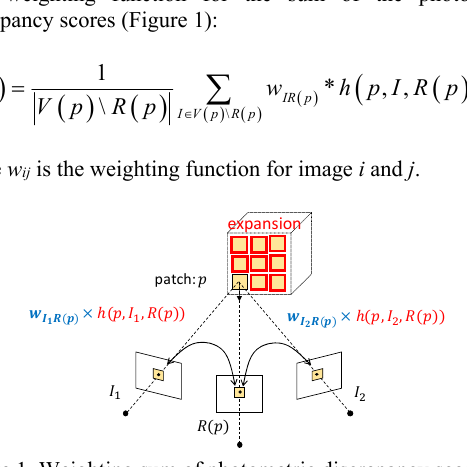
Figure 1. Weighting sum of photometric discrepancy scores for patch